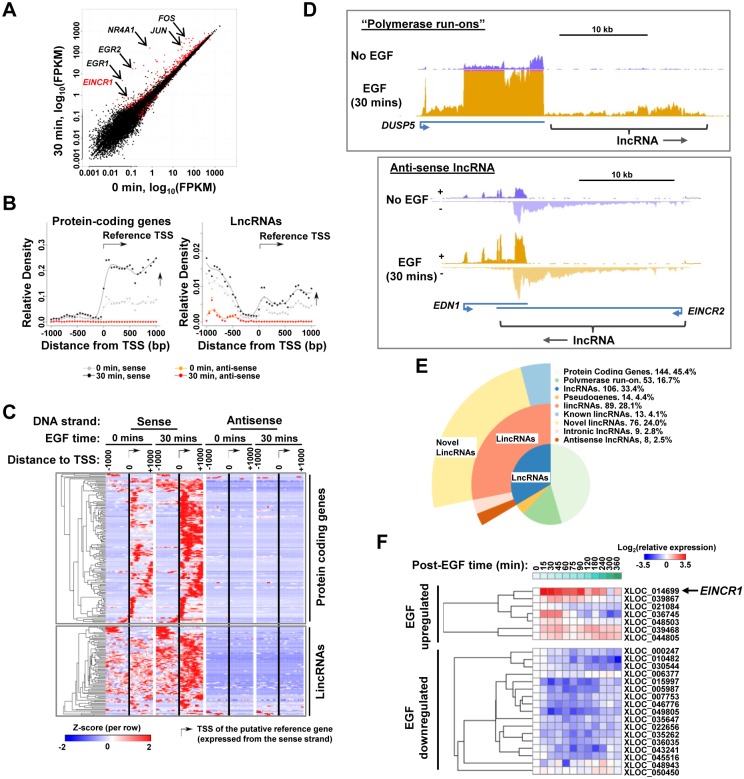
EGF-stimulation leads to transcriptional induction of lncRNAs.(A) Scatter plot of differential gene expression before (0 min) and after (30 min) EGF stimulation. The identities of several upregulated protein coding genes and the lincRNA EINCR1 are indicated. (B) Average profiles of sequencing read density in the 2000 bp window around the putative transcription start sites (TSS) of EGF-upregulated protein-coding genes and lincRNAs. (C) Heat map showing the sequencing read density in the 2000 bp window around the putative transcription start sites (indicated by arrows) of EGF-upregulated protein-coding genes and lincRNAs. Data are row Z-normalised. (D) Example genome browser views of RNAseq reads located around the DUSP5 (top) and EDN1 (bottom) loci. LncRNAs located immediately downstream from DUSP5 (“polymerase run on”) and on the anti-sense strand downstream from EDN1 (EINCR2) are shown. (E) Distribution of EGF-upregulated genes across gene classes defined by the ENCODE project. The percentage of transcripts falling into each class is indicated. (F) RT-qPCR analysis of the expression of the indicated up- and down-regulated lincRNAs following EGF induction for the indicated times. Data are shown according to the indicated colour coding (capped at log2≤3.5) and are the average of three biological replicates (n = 3).